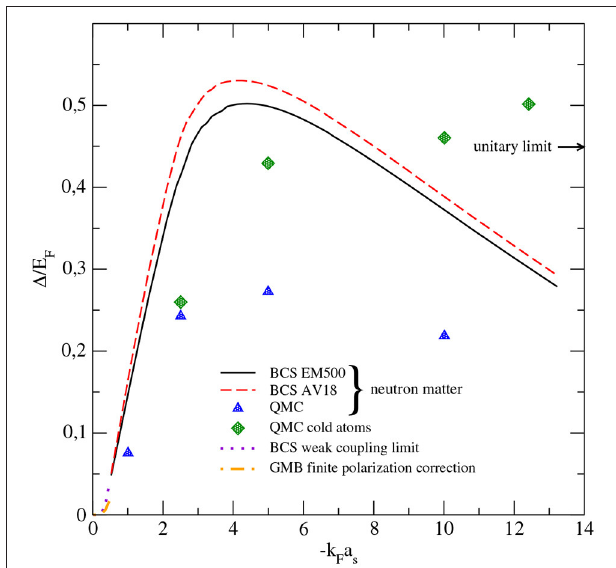
FIGURE 3 | Superfluid 1 S 0 pairing gap (in units of E F ) of low-density neutron matter as a function of the dimensionless parameter − k F a s . BCS results obtained with the EM500 interaction and the AV18 potential are shown together with the QMC ones (full triangles) of reference [ 27]. The superfluid pairing gap for cold atoms (full diamonds), calculated also by the authors of reference [27], is shown for comparison. The dotted and dot-dashed lines at very low values of − k F a s display, respectively, the BCS result in the weak coupling limit and the Gorkov and Melik-Barkhudarov (GMB) [ 83] finite polarization correction. The arrow indicates the value of 1/ E F at the unitarity limit extracted from ultra-cold Fermi atoms experiments with imbalance mixtures of 6 Li